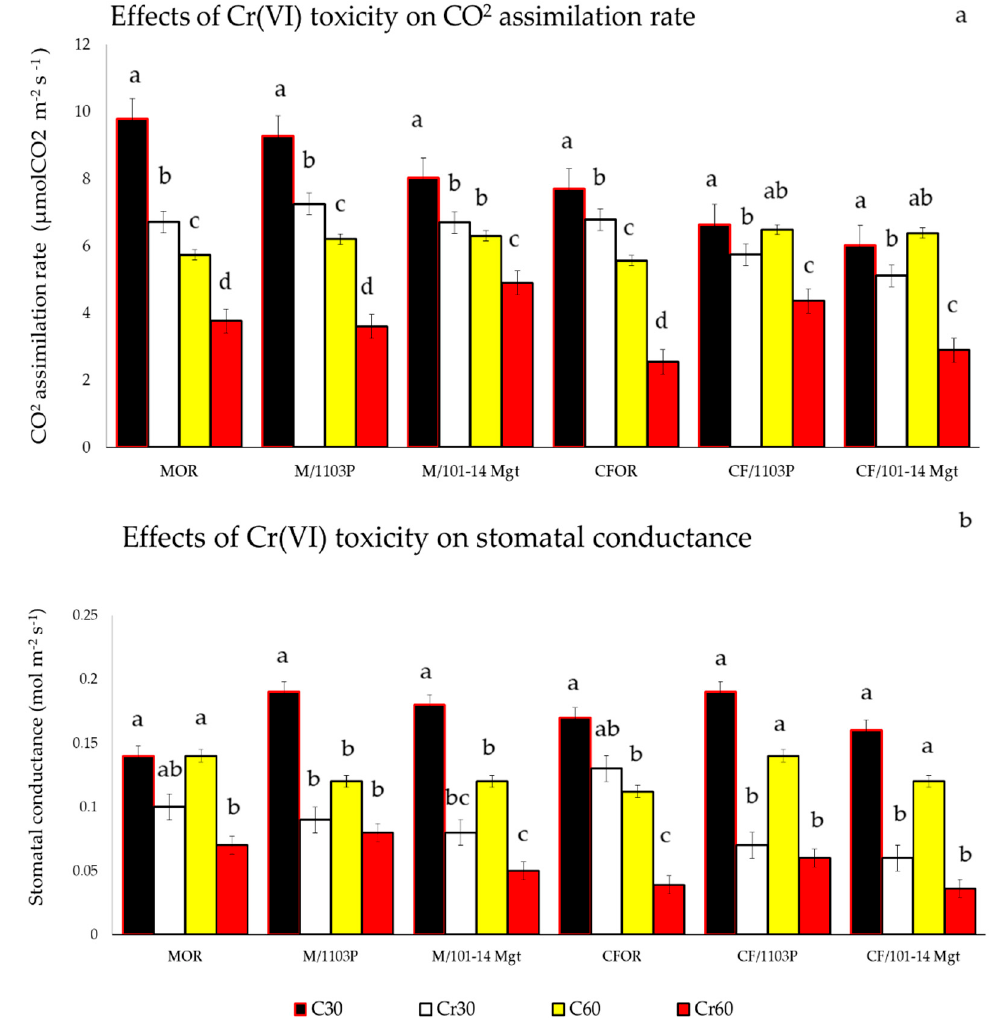
Figure 6. Net CO 2 assimilation rate ( a ) and stomatal conductance ( b ) of Merlot (M) and Cabernet Franc (CF) grapevine cultivars on their own roots (OR) and on 1103P and 101-14 Mgt rootstocks thirty and sixty days after the start of the Cr(VI) treatments. C: control; Cr: Cr(VI) treatment; 30 and 60 (at days thirty and sixty, respectively). Net assimilation rate (F:21.174). Stomatal conductance (F: 1.475). Different letters represent significant difference of p < 0.05.